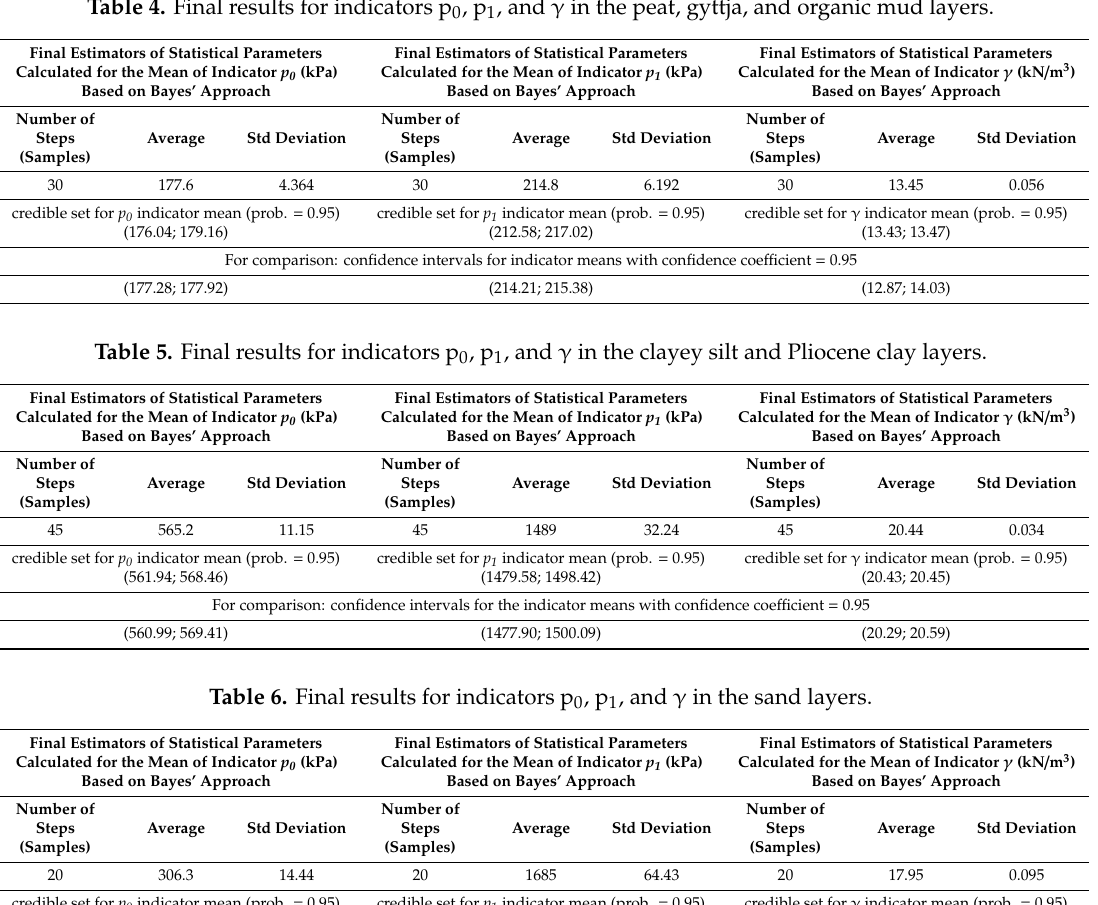
For comparison: confidence intervals for indicator means with confidence coe ffi cient =